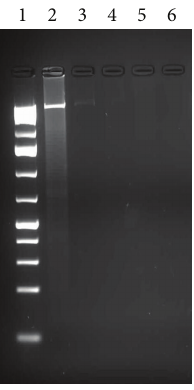
Figure 3: Agarose gel (1,5%) profile of DNA from MCF-7 cells treatedwithacetoneextractof S.birrea .Effectofdifferentconcentra- tions of acetone extract (EA) after 24h incubation. Lane 1: molecular weight marker, lane 2: untreated MCF-7 cells, note that cells were unaffected, lane 3: treated cells with IC 50 conc. DNA concentration diminishes with a visible faint band. Lane 4: treated cells with IC 50 × 2 conc, faint band completely disappears; in subsequent lanes. Lane 5: treated cells with IC 50 × 4 conc. Lane 6: treated cells with IC 50 × 8